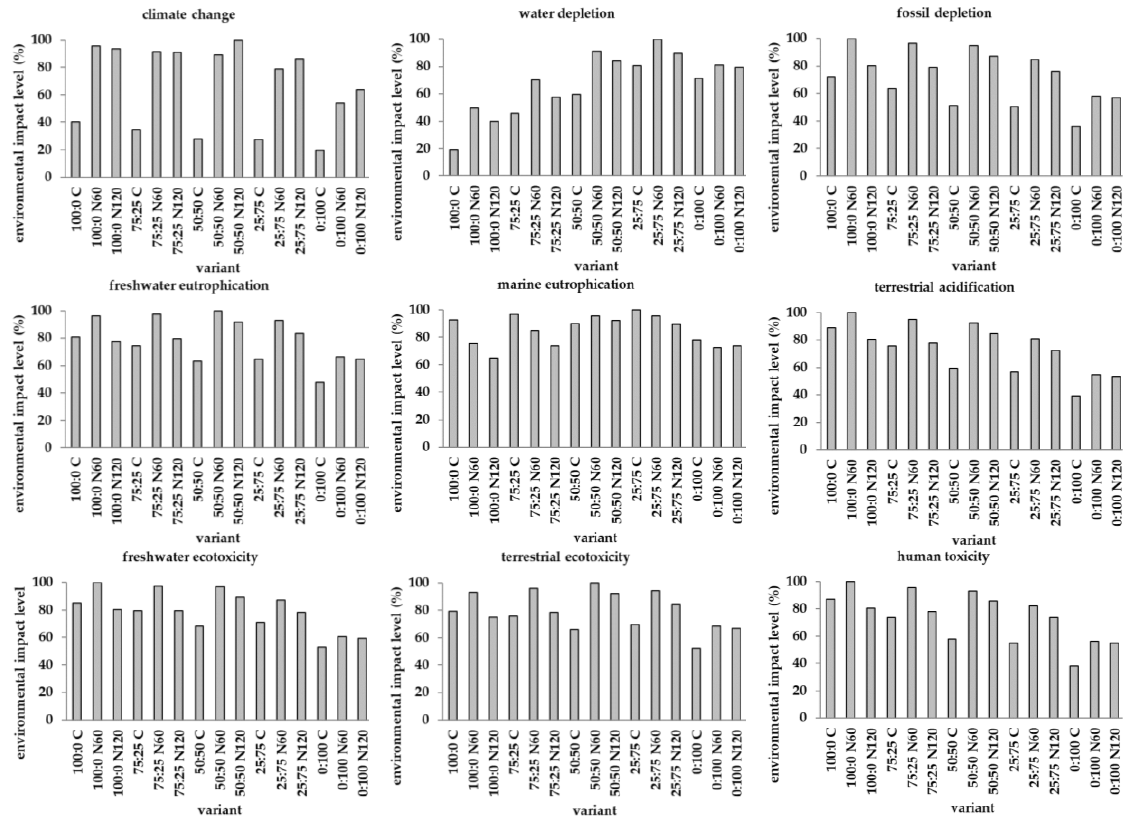
Figure 1. Trends of the environmental impact per 1 kg of grain N yield ha − 1 (in %).C = Control; N60 = variant with input of 60 kg N ha − 1 ; N120 = variant with input of 120 kg N ha − 1 ; Sowing ratios of oat:pea (%:%): 100:0, 75:25, 50:50, 25:75, and 0:100; SimaPro 9.1.1.1 software; ReCiPe 2016 Midpoint (H) V1.05/World (2010) H; Cut-off System Model approach; Characterization